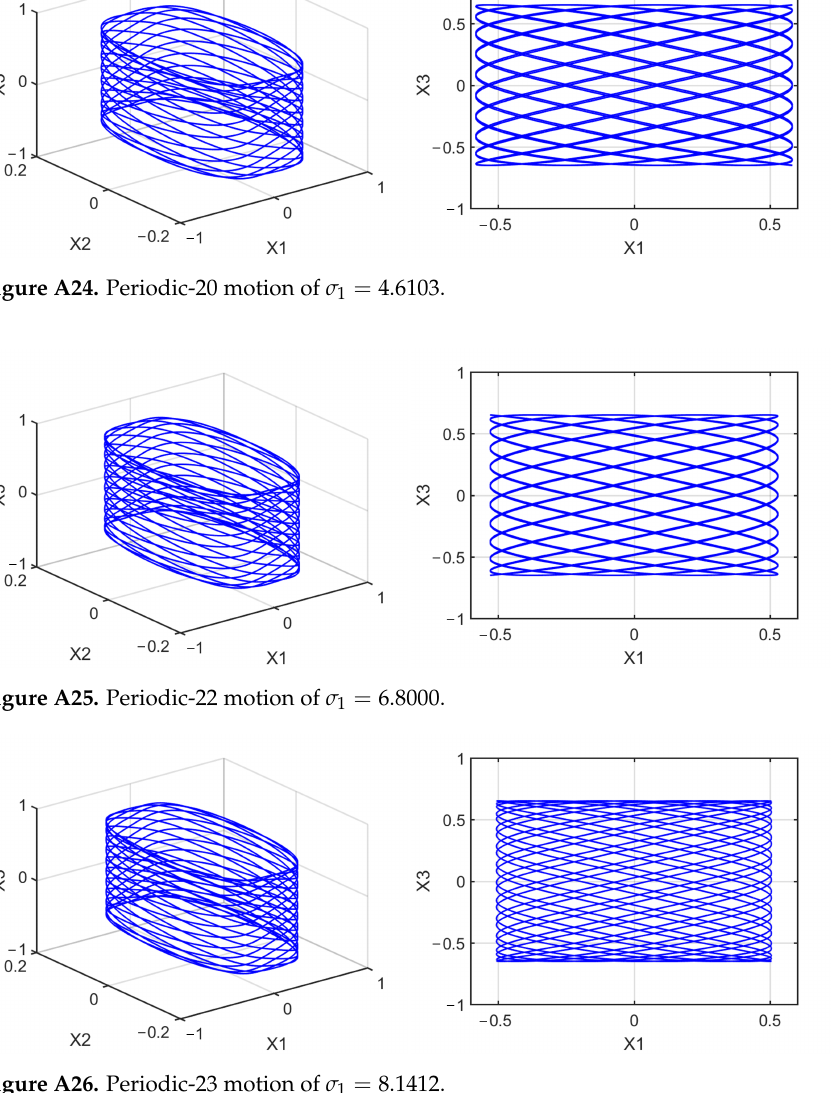
Figure A26. Periodic-23 motion of σ 1 =